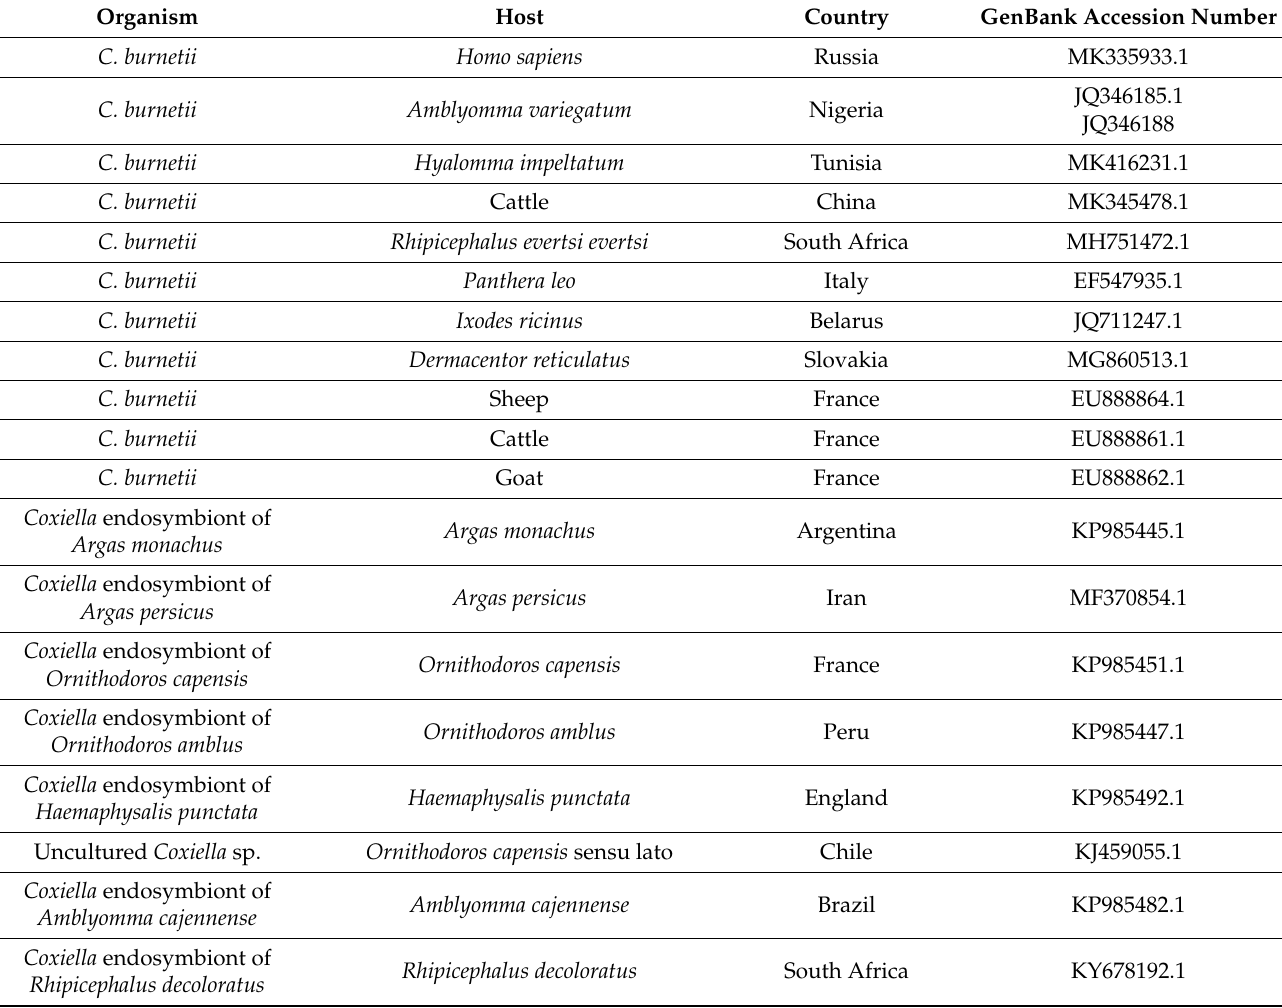
Table 1. GenBank accession numbers of sequences used for phylogenetic analysis 1